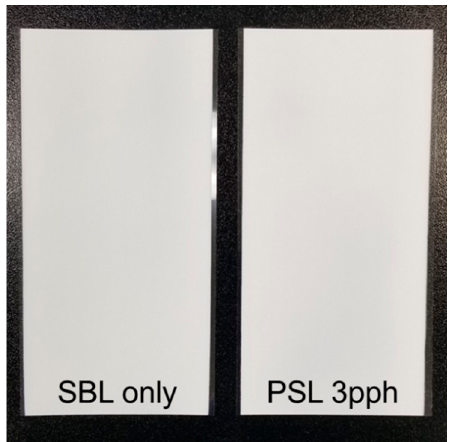
Figure 1. Digital image of coated polyester films: coatings without ( left ) and with 3 pph ( right ) the PS latex cobinder. SBL = styrene/butadiene (S/B) latex; PSL = polymer-stabilized (PS) latex.